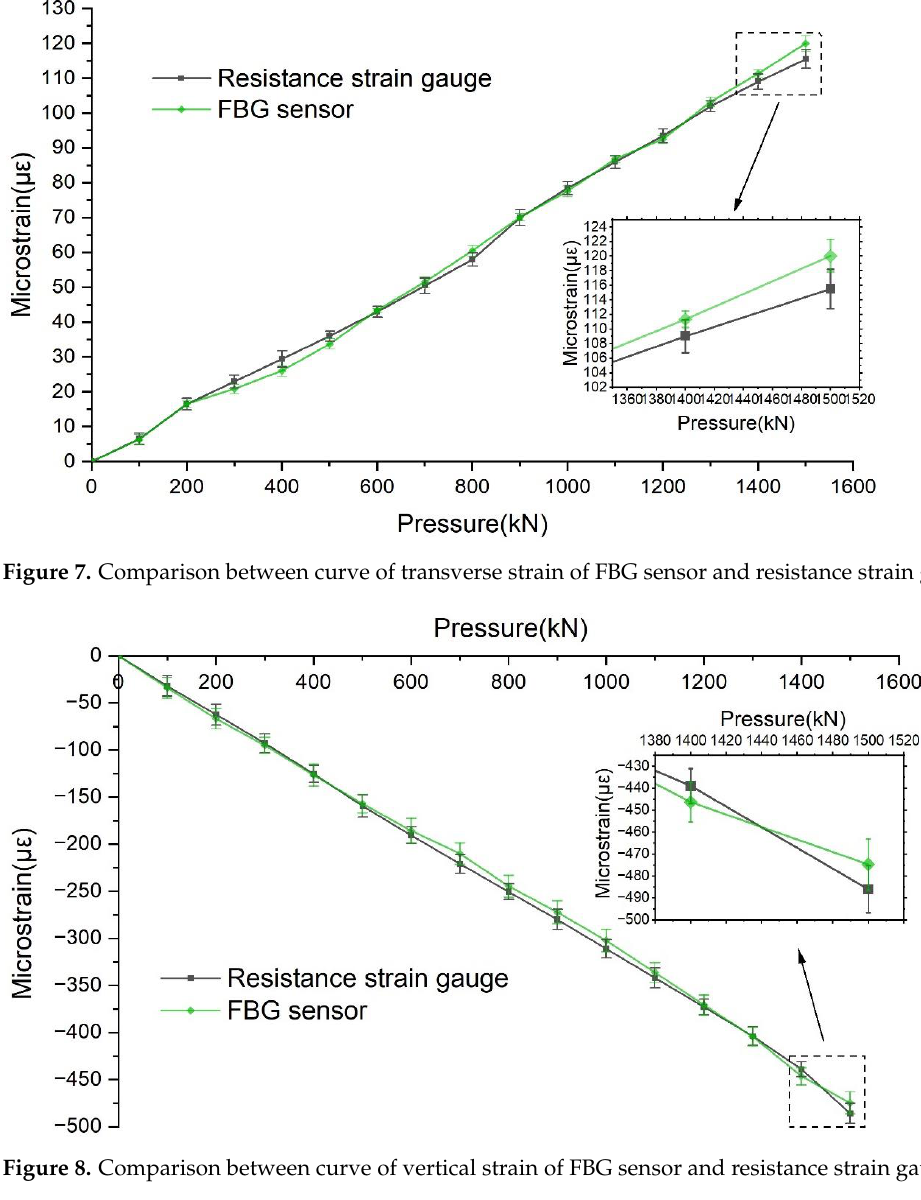
Figure 8. Comparison between curve of vertical strain of FBG sensor and resistance strain gauge.